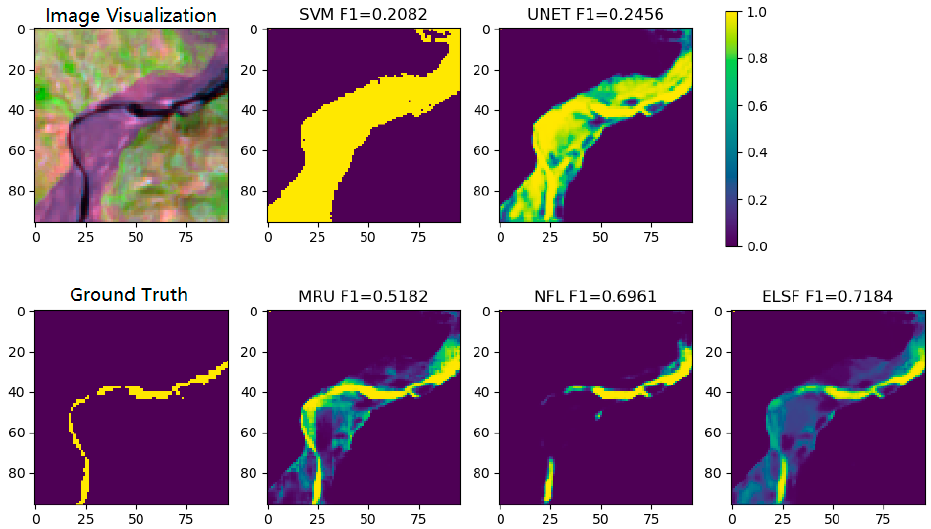
Figure 14. Figures of sample visualization, SVM, UNet segmentation fraction results (row 1), sample ground truth, MultiResUNet, NFL, ELSF segmentation fraction results (row 2).